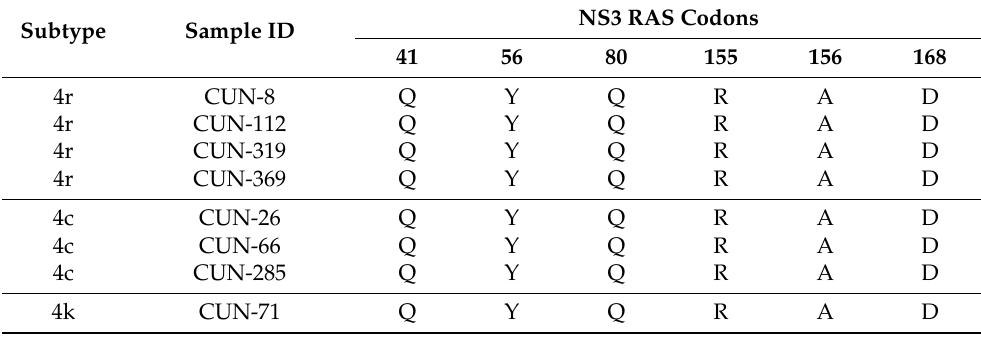
Table 3. Baseline amino acids found at the main resistance-associated substitution (RAS) positions in NS3